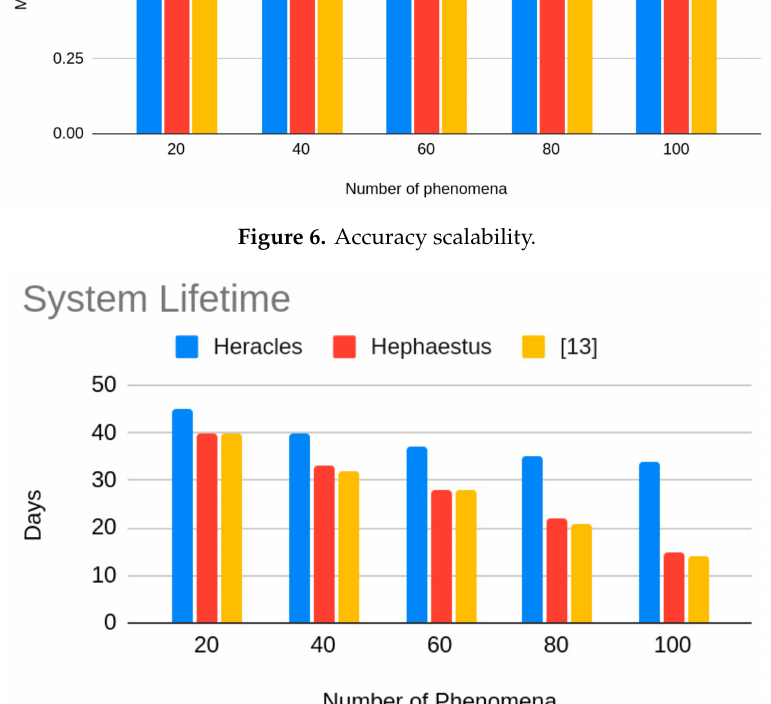
Figure 7. System lifetime